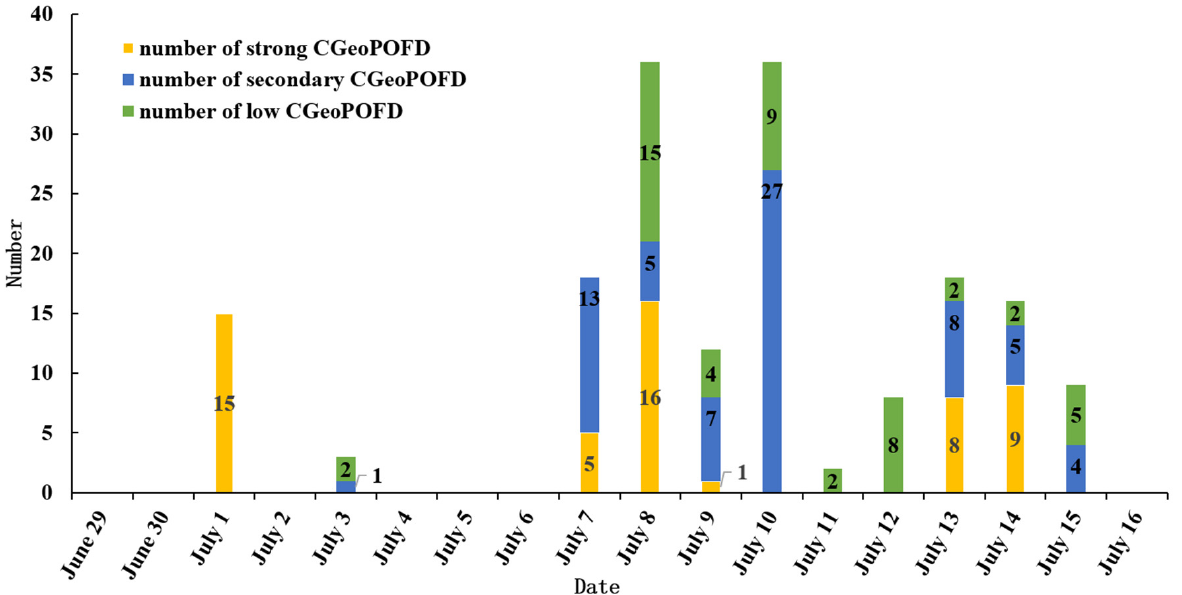
Figure 4. The temporal evolution of the number of